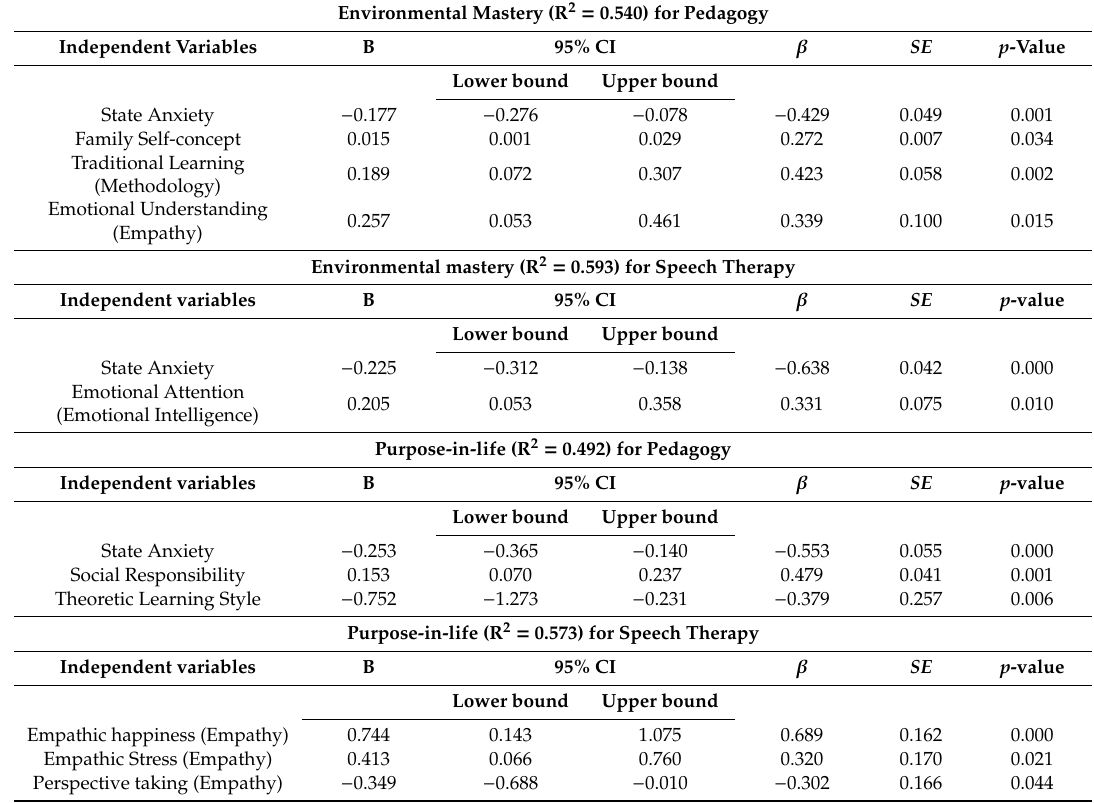
Table 4. Influence of psychosocial factors on psychological well-being in university students according to the academic program—Pedagogy or Speech